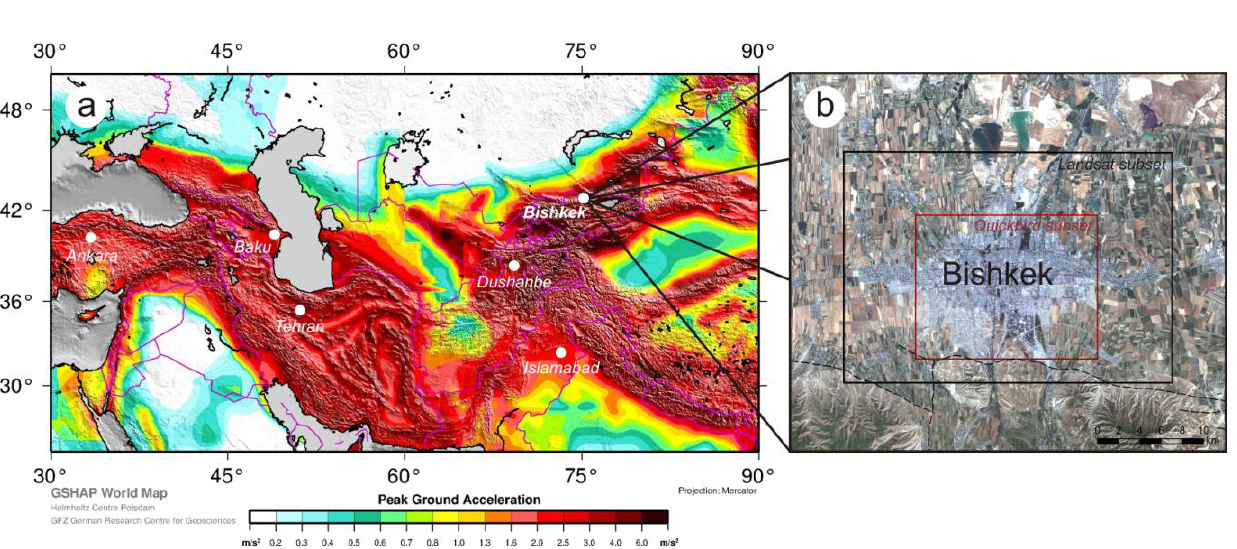
Figure 1. ( a ) Location and seismic hazard of the study area (GSHAP [11]); ( b ) Bishkek urban area overview, showing the extent of the Landsat and Quickbird images used (background image: Landsat TM,